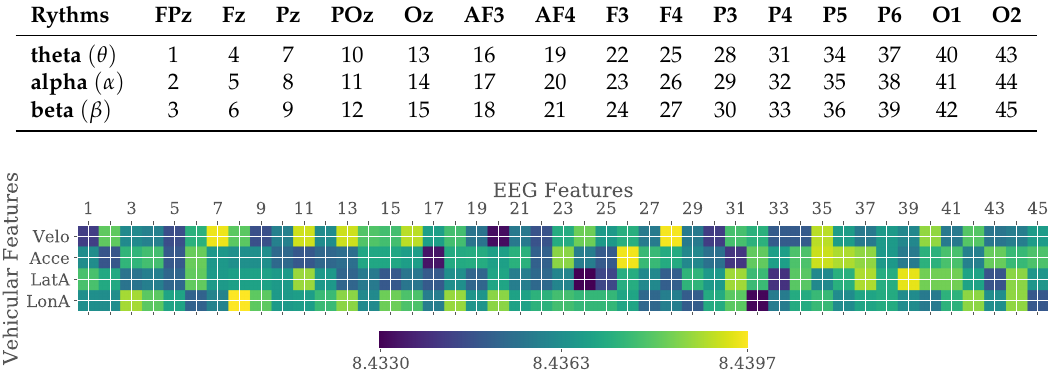
Figure 5. Calculated MI values between EEG and vehicular signal. The columns of the matrix correspond to 45 features extracted from EEG signals and the rows corresponds to four vehicular features: Velocity (Velo), Acceleration (Acce), Lateral Acceleration (LatA) and Longitudinal Acceleration (LonA). The color bar below illustrates the range of values for each pair of EEG and vehicular features where dark blue on the left corresponds to low mutual information and gradually higher mutual information values towards right are represented by yellow. Table 2. List of different feature sets and corresponding number of features used for validating the proposed